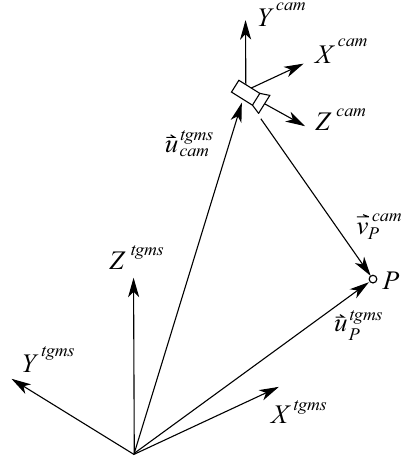
Figure 5. TGMS frame and camera